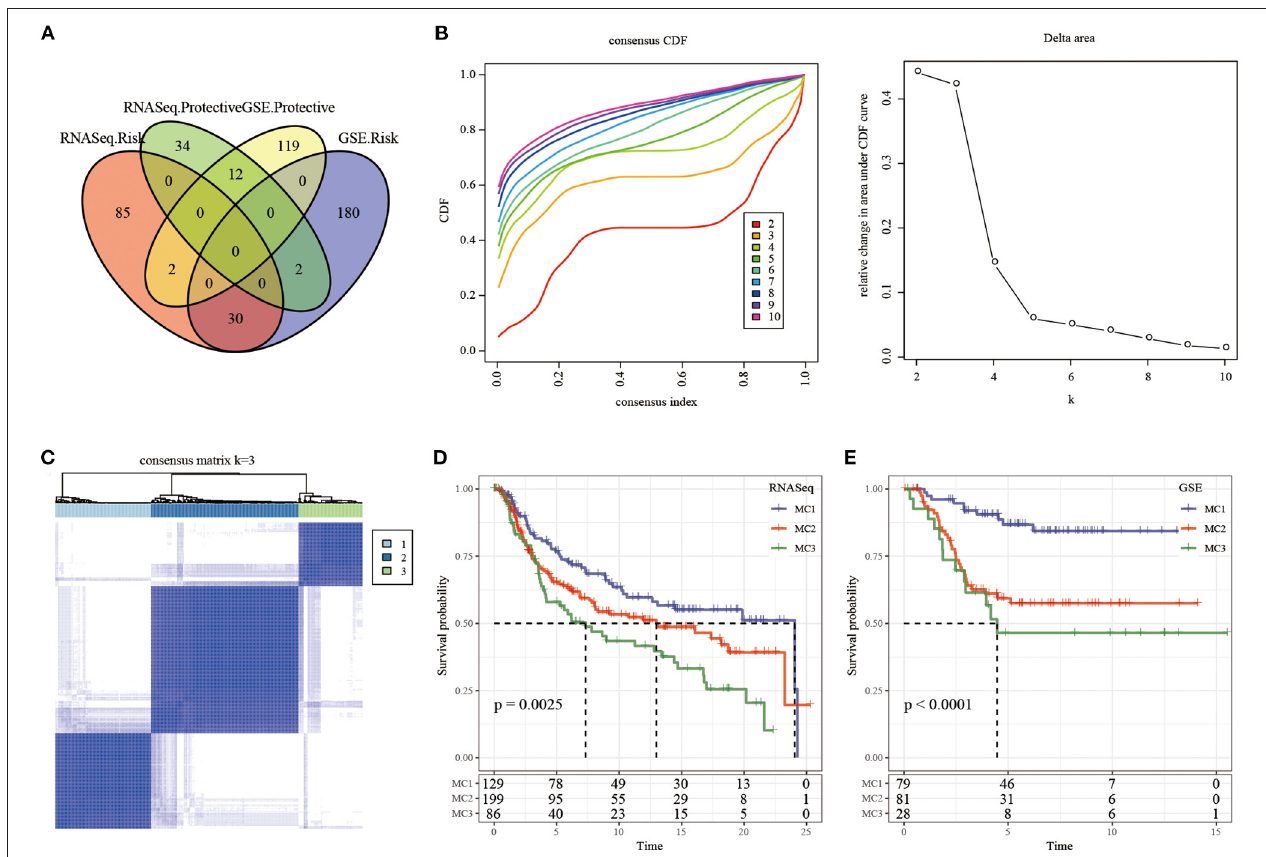
FIGURE 2 | The Metabolism Cluster in TNBC. (A) Intersection Venn diagram of metabolic genes with significant prognosis in the two cohorts; (B) CDF curve of TCGA cohort samples and CDF Delta area curve, Delta area curve of consensus clustering, indicating the relative change in area under the cumulative distribution function (CDF) curve for each category number k compared with k – 1. The horizontal axis represents the category number k and the vertical axis represents the relative change in area under CDF curve; (C) consensus k = 3 sample clustering heat map; (D) KM curve of the prognosis of the three subtypes in the RNASeq dataset; (E) KM curve of the prognosis of the three subtypes in the GSE dataset.